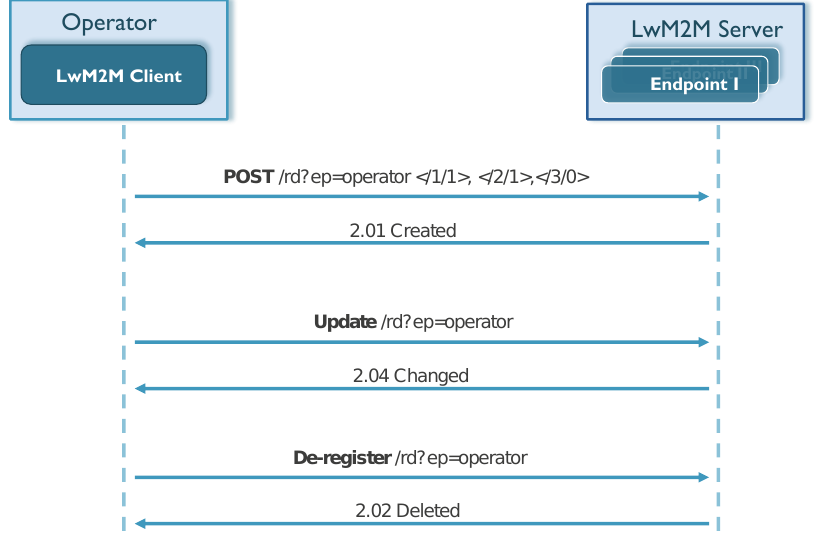
Figure 4. LwM2M resource registration example